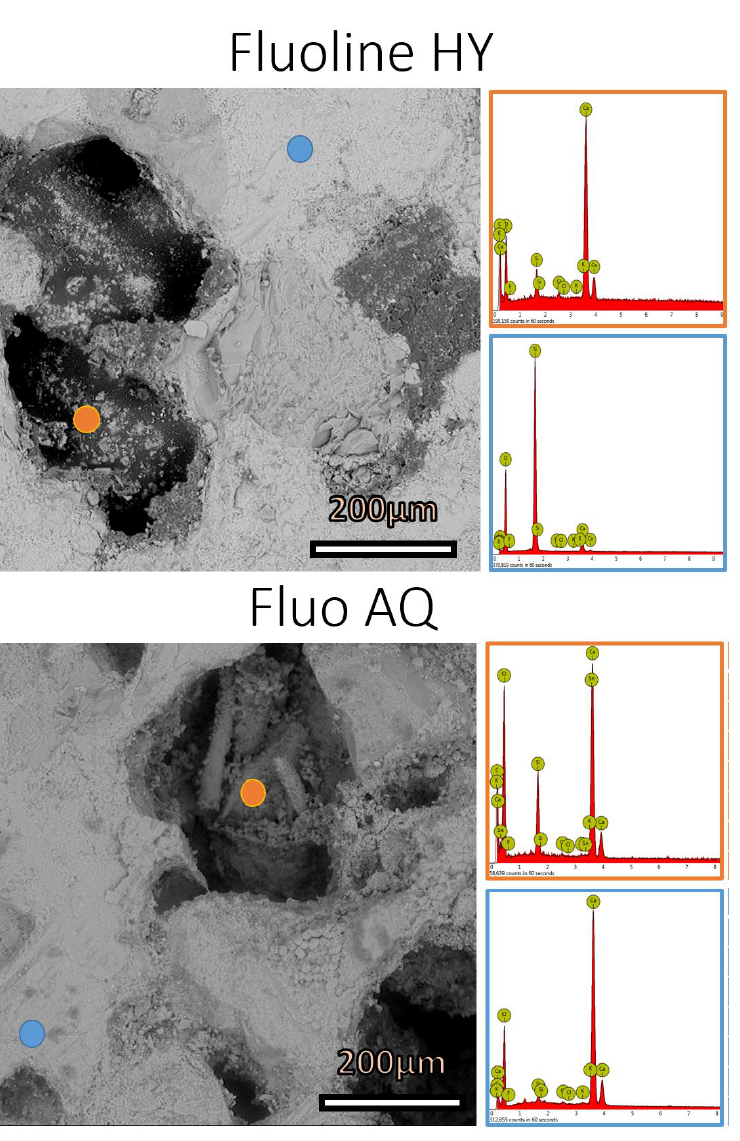
Figure 1. SEM micrographs with respective EDS spectra obtained for stone treated with Fluoline HY ( top ) and Fluo AQ ( bottom ). The coloured points indicate the spots where the EDS analysis was performed. The colour of the border for the EDS spectra and the atomic concentration results of spectra data analysis correspond to the spot colour.